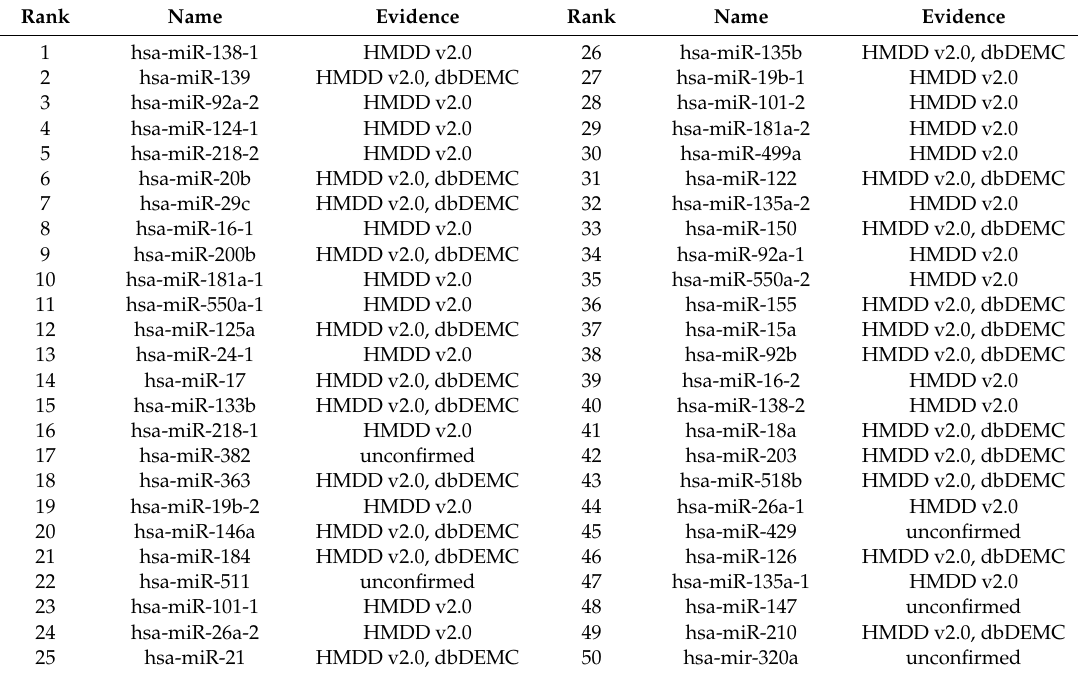
Table 4. Prediction of top 50 lymphoma